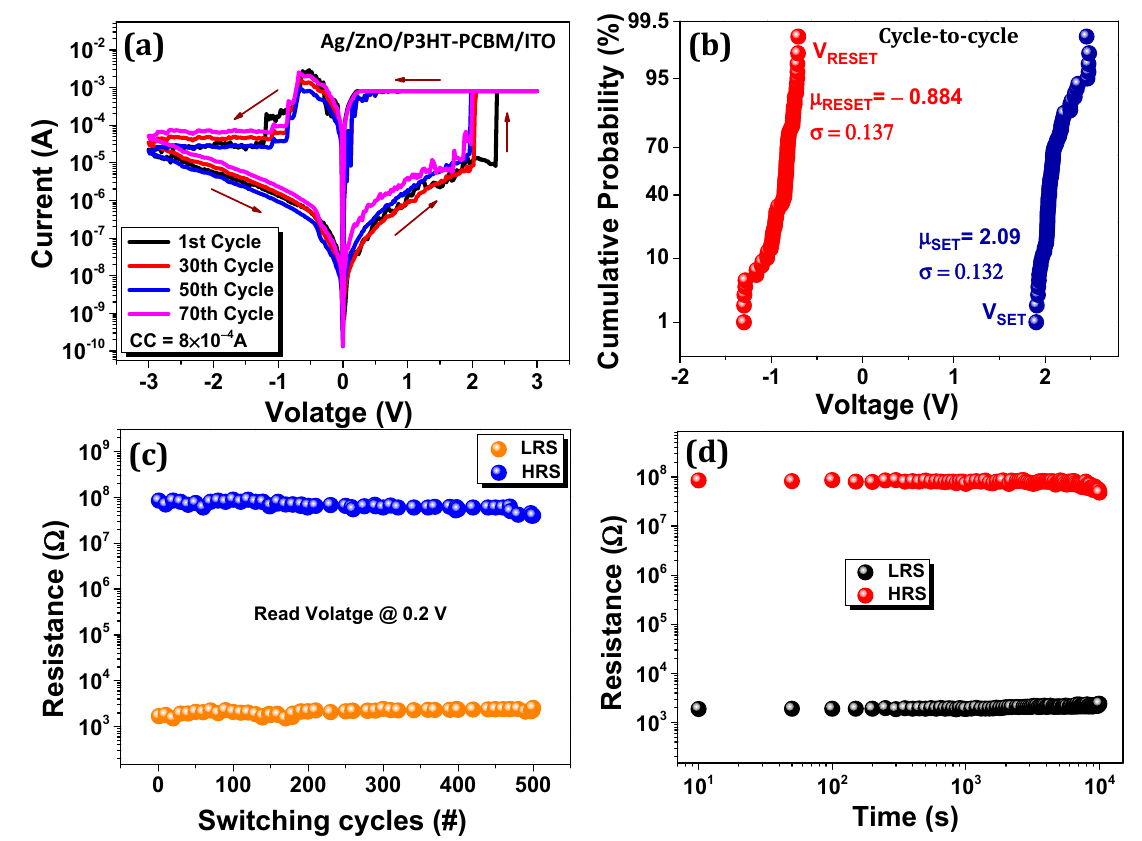
Figure 2. ( a ) Typical I-V characteristic of Ag/ZnO/P3HT-PCBM/ITO in semilogarithmic plot. ( b ) Cumulative probability of SET/RESET voltages; ( c ) DC sweep mode endurance cycles at read voltage 0.2 V, respectively; ( d ) Retention property in both LRS and HRS at read voltage 0.2 V.